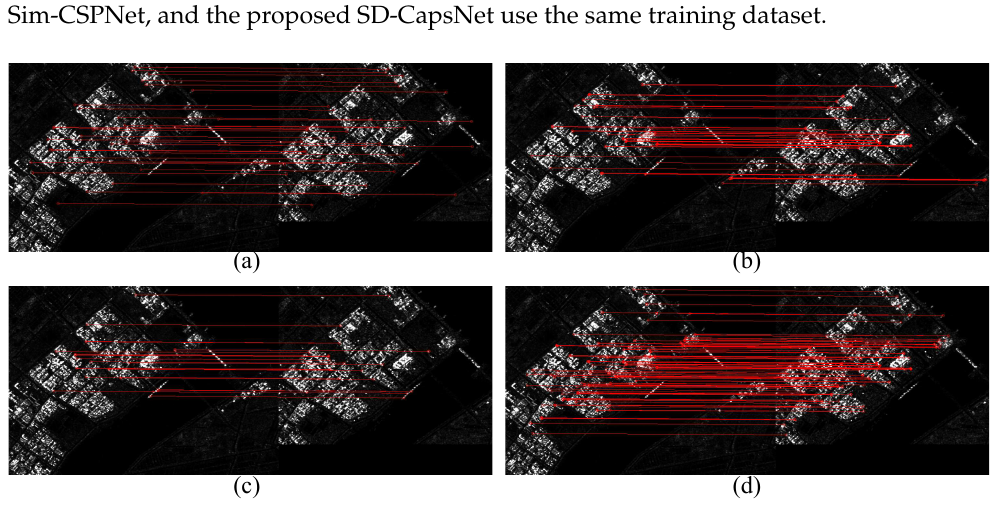
Figure 12. The feature descriptor matching results with different methods for pair 1. ( a ) SAR-SIFT. ( b ) SOSNet. ( c ) Sim-CSPNet. ( d ) Our proposed